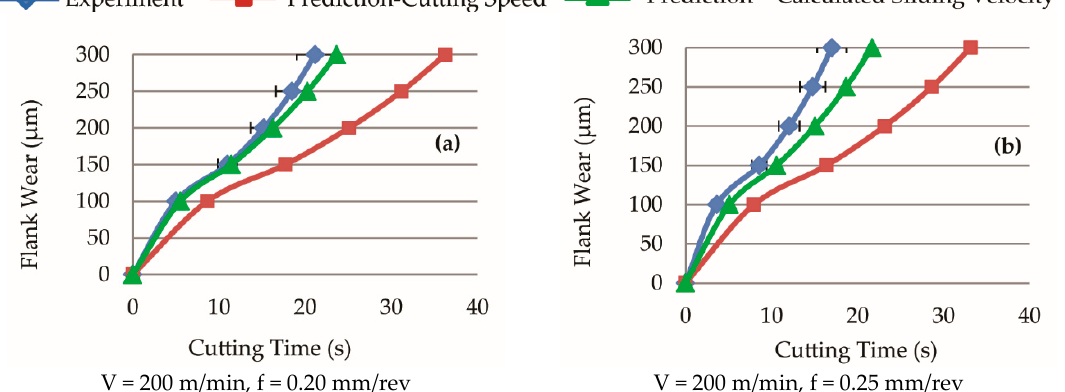
Figure 18. Predicted tool life according to original Usui and modified Usui in comparison with experiment.